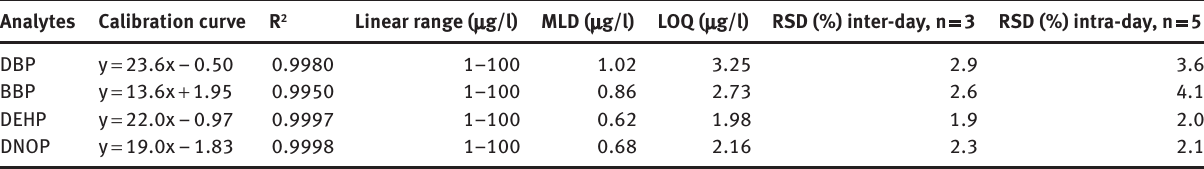
Table 2: Analytical performance of the developed method. Analytes Calibration curve R